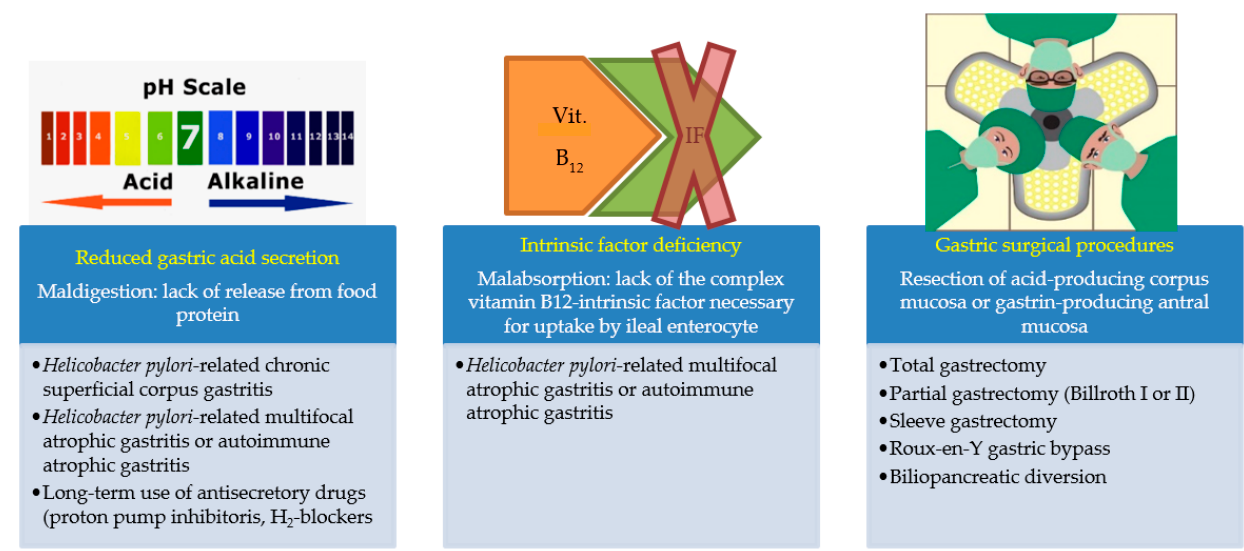
Figure 1. Vitamin B 12 deficiency may be caused, besides reduced intake, by three different